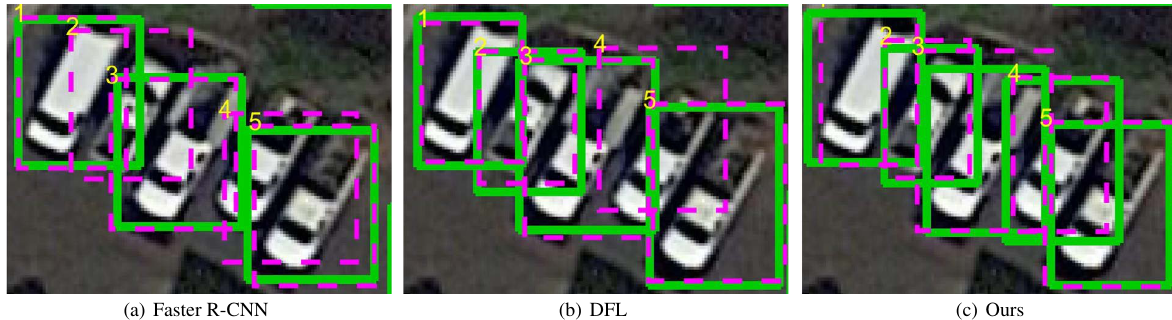
Figure 7. Qualitative comparison of the generalization ability. The green boxes denote detection results given by the model that was trained on DOTA. The dashed purple boxes denote detection results of a model trained on VEDAI. We use a dashed yellow box to highlight a challenging image region that can be handled correctly by our method.